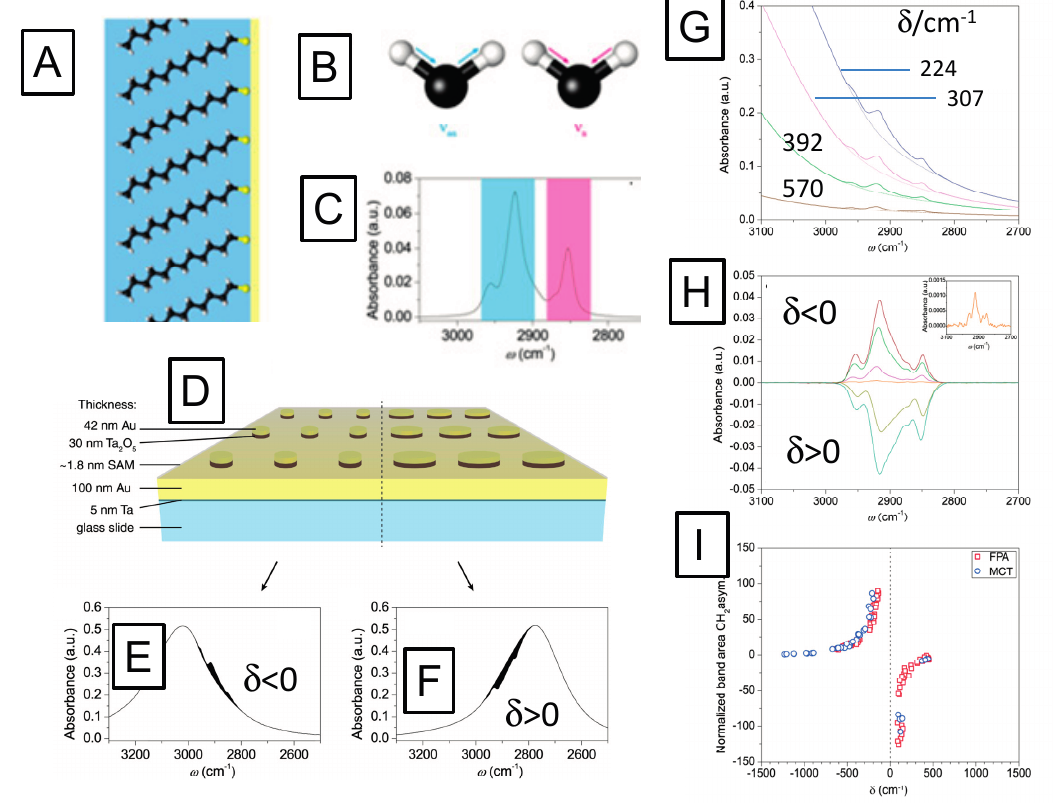
Figure 7. ( A ), schematic representation of a self-assembled monolayer of dodecanethiol on gold; the hydrocarbon chains consisting of CH 2 groups and a CH 3 terminal group; ( B ) schematics of the asymmetric (blue) and symmetric (magenta) stretching modes of CH 2 groups: ( C ) IR spectrum of the asymmetric (blue) and symmetric (magenta) stretching modes of CH 2 vibrations; ( B ) ATR IR absorption spectrum of dodecanethiol corresponding to the stretching modes depicted in (B); ( D ) Schematic picture of two-dimensional arrays of Ta 2 O 5 /Au nanodiscs with different radii, however, identical disc-disc separation distance; ( E ) reflection/absorption spectrum of a nanodisc array with the spectral position of the plasmon excitation at higher wavenumbers than the molecule vibrations (spectral difference δ < 0) enhances the molecular absorption, while the array with larger particle diameters ( F ), showing a plasmonic resonance at lower wavenumbers than the molecular vibration, i.e. , with spectral difference δ > 0, suppress the molecular vibrations which lowers the total absorbance; ( G ) infrared absorbance spectra of dodecanethiol monolayers adsorbed onto nanodisc arrays. The intensities of methyl and methylene stretching bands increase for lower δ values, i.e. , for structures which exhibit the plasmon resonance closer to the molecular vibrations; ( H ) baseline-corrected IR spectra of the C–H vibrations for different δ -values. Negative δ -values lead to enhanced absorption, whereas positive δ - values result in negative difference spectra; ( I ) normalized band areas measured at various spectral